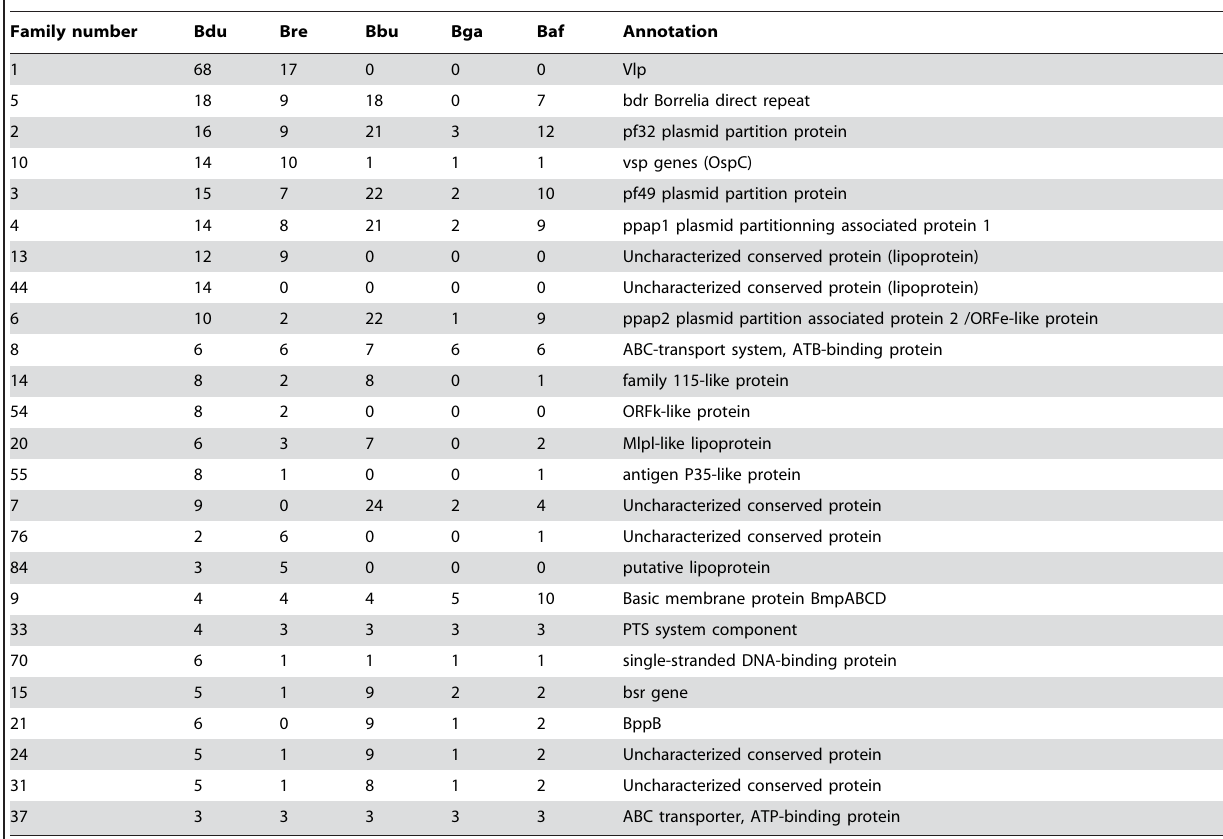
Table 2. Borrelia gene